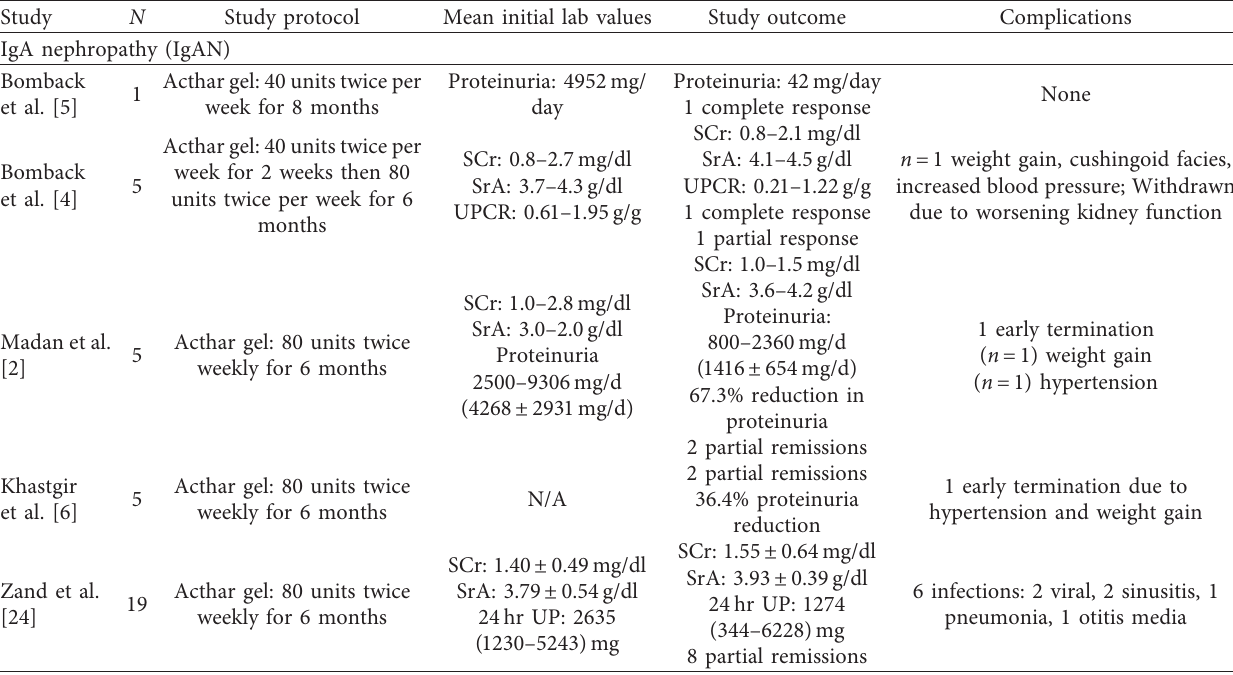
Table 9: Summary of studies on ACTH in IgA nephropathy.